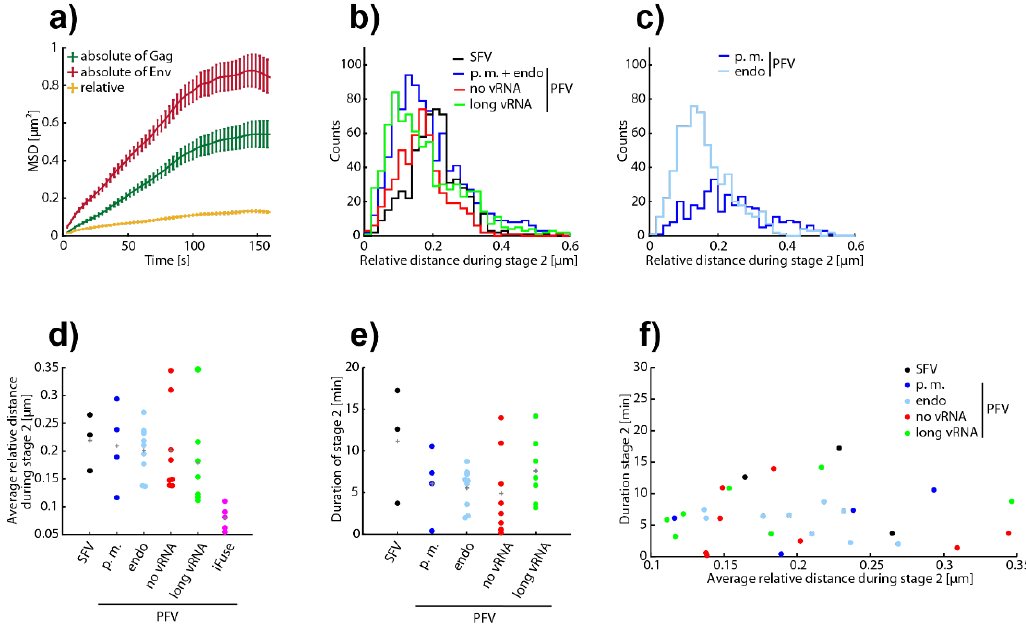
Figure 5. The intermediate stage during the fusion process. ( a ) A mean-square displacement (MSD) analysis of the absolute trajectory of the envelope signal (red), the absolute trajectory of the capsid (green) and of the relative trajectory of the envelope with respect to the capsid (yellow) during stage 2 of a SFVmac fusion event. The relative diffusion coefficient is clearly smaller than the absolute diffusion coefficients indicating that the two signals are tethered together. The Env protein diffuses faster than the Gag protein. Error bars show the standard error of the mean of the squared displacement. ( b ) Image-wise histograms of the relative distance of the capsid and envelope component within the intermediate step of the fusion process. PFV particles (blue) show a shift towards lower distances compared to SFVmac (black) or particles without a viral genome (red). ( c ) Image-wise histograms of the relative separation of envelope and capsid depending on whether fusion occurred from the plasma membrane (dark blue) or from endosomes (light blue). ( d ) A comparison of the average separation of the envelope from the capsid plotted per event for different types of FV particles. ( e ) A comparison of the average duration of the intermediate state per event for different types of FV particles. ( f ) A scatter plot of the average envelope-capsid separation versus duration of the intermediate fusion state for different types of FV particles. FV particle types: SFVmac virions at endosomes (SFV); PFV virions at the plasma membrane (PFV p.m.); PFV virions at endosomes (PFV endo); PFV virions that do not contain viral RNA (PFV no vRNA); PFV virions with longer viral RNA (PFV long vRNA); fusion incompetent PFV virions (PFV iFuse).